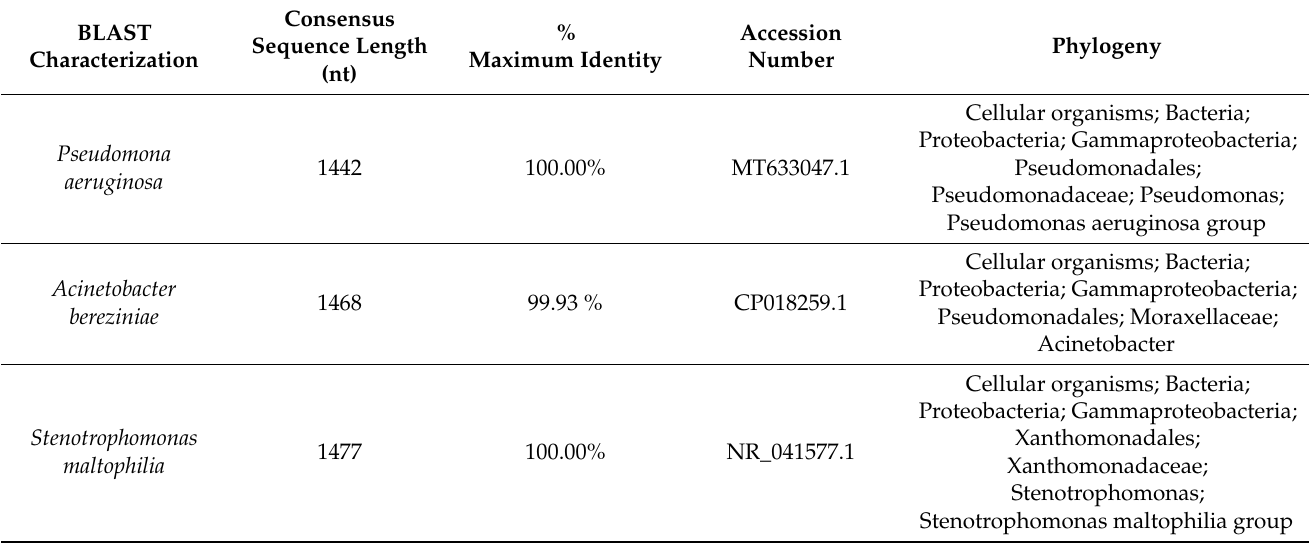
Table 1. BLAST characterization of the rDNA sequence of bacteria isolated from the MFC anode plate with onion substrate.